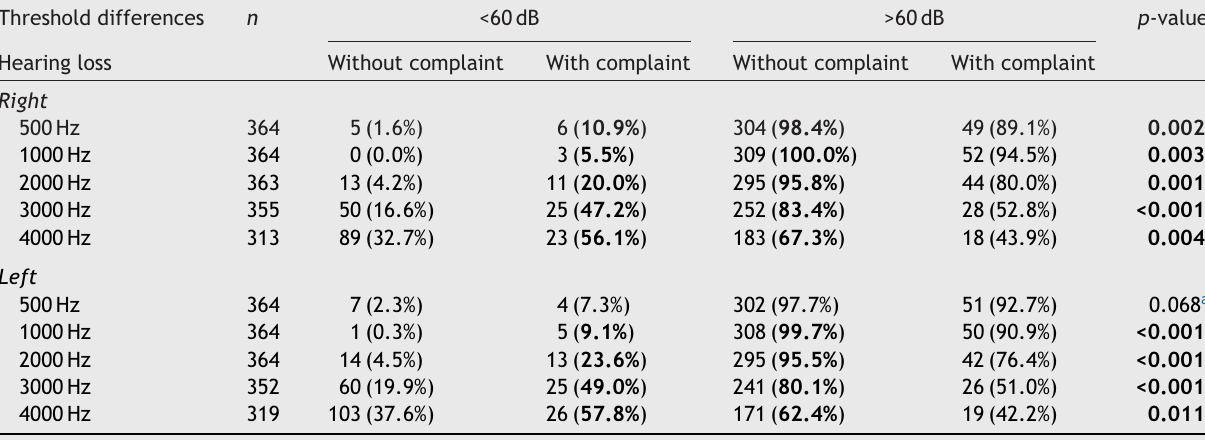
Comparison between hearing loss complaints and occurrence of Metz recruitment. Threshold